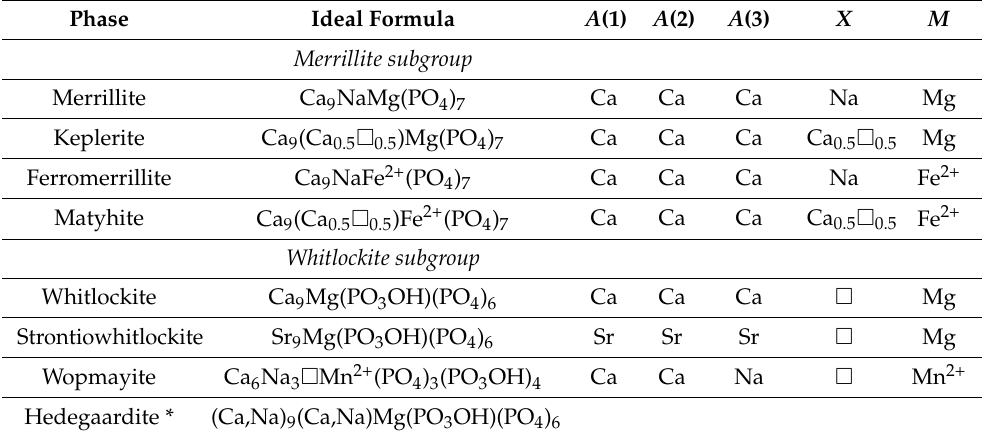
Table 1. Whitlockite-group minerals approved by the IMA-CNMNC: ideal formula and cation